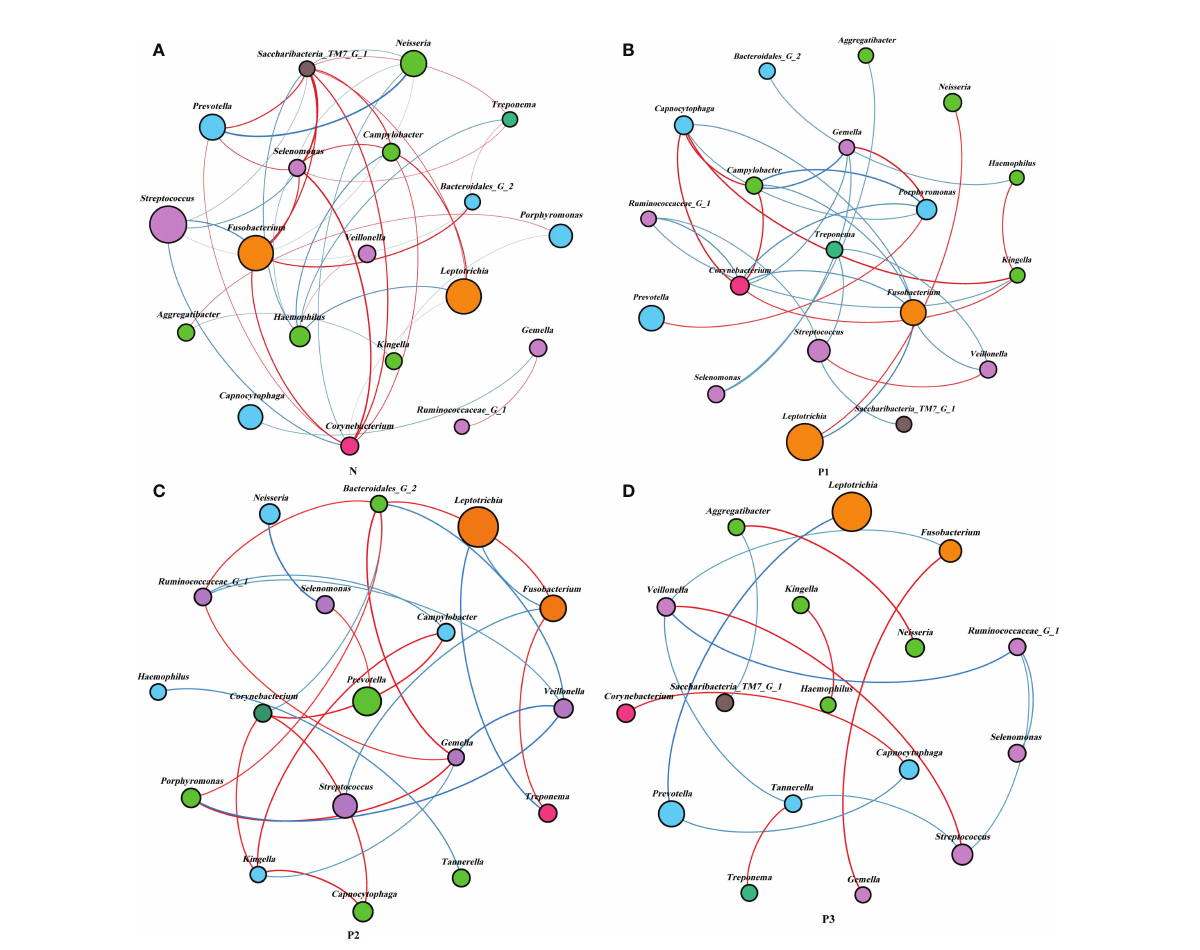
FIGURE 4 Network analysis between bacterial taxa in the four groups. Network analysis revealed the 20 most abundant genera (|SpearmanCoef>0.6 and P <0.05). Bacterial interactions in N (A) , P1 (B) , P2 (C) , and P3 (D) are depicted. The size of the nodes is proportional to the genus abundance. Node color corresponds to the phylum classi fi cation. Edge colors indicate positive (red) and negative (blue)